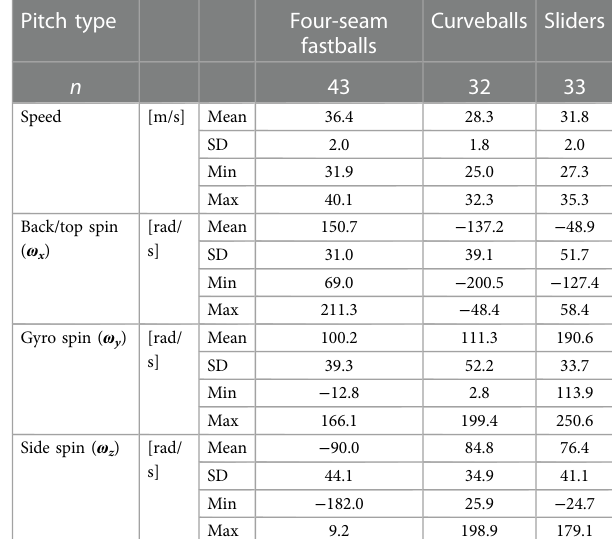
TABLE 1 The ball speed and angular velocity of each pitch type. The positive values of the top/backspin ( ω x ) indicate the backspin. The positive values of the gyro spin ( ω y ) indicate that the ball rotates clockwise about the Y-axis from the pitcher ’ s perspective. The positive values of the sidespin ( ω z ) indicate that the ball rotates counterclockwise about the Z-axis viewed from